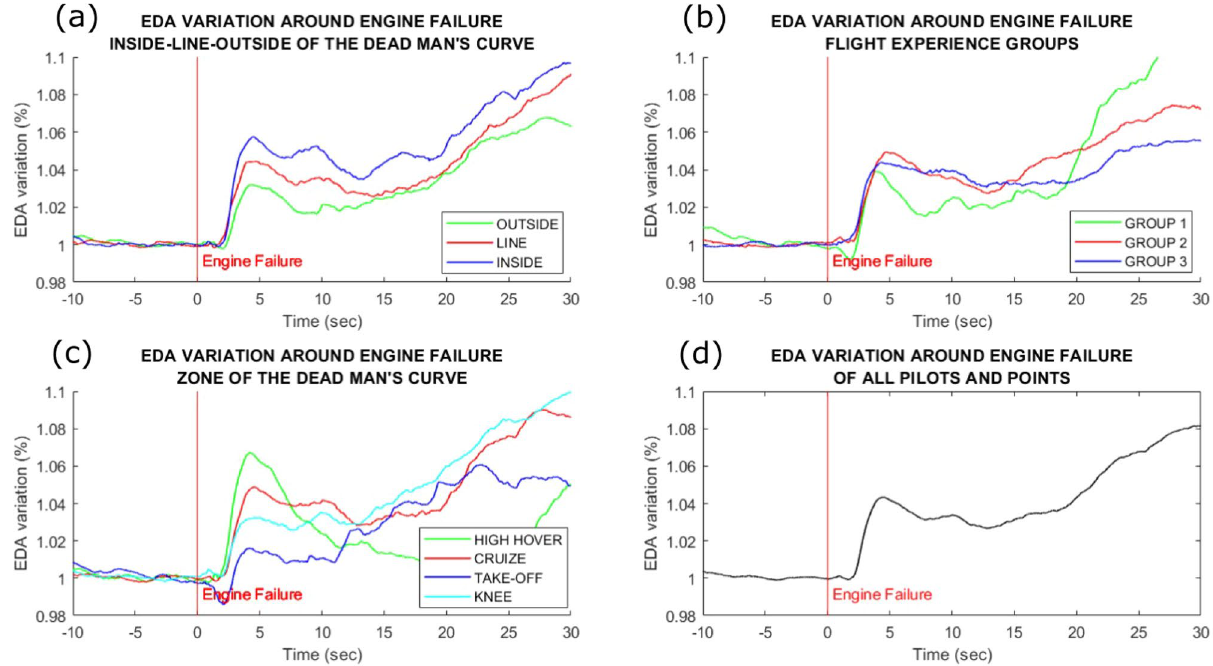
Figure 6. Electrodermal activity modulation after the engine failure: (a) mean EDA of maneuvers inside, outside or at the line limit of the height-speed diagram. (b) Mean EDA between different groups of pilot expertise: Group 1 (test Pilots with extensive autorotation experience), Group 2 (test Pilots with lesser autorotation experience) and Group 3 (operational pilots with lesser autorotation experience). (c) Mean EDA results for the four zone regions. The high-hover amplitude was significantly higher than Take-off and Knee amplitudes. (d) Mean EDA response around the engine failure for all maneuvers. We emphasize